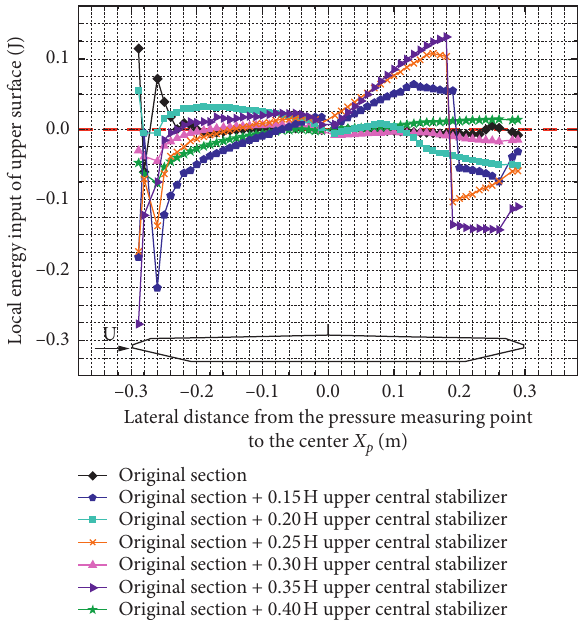
Figure 19: The local energy input of the upper surface.